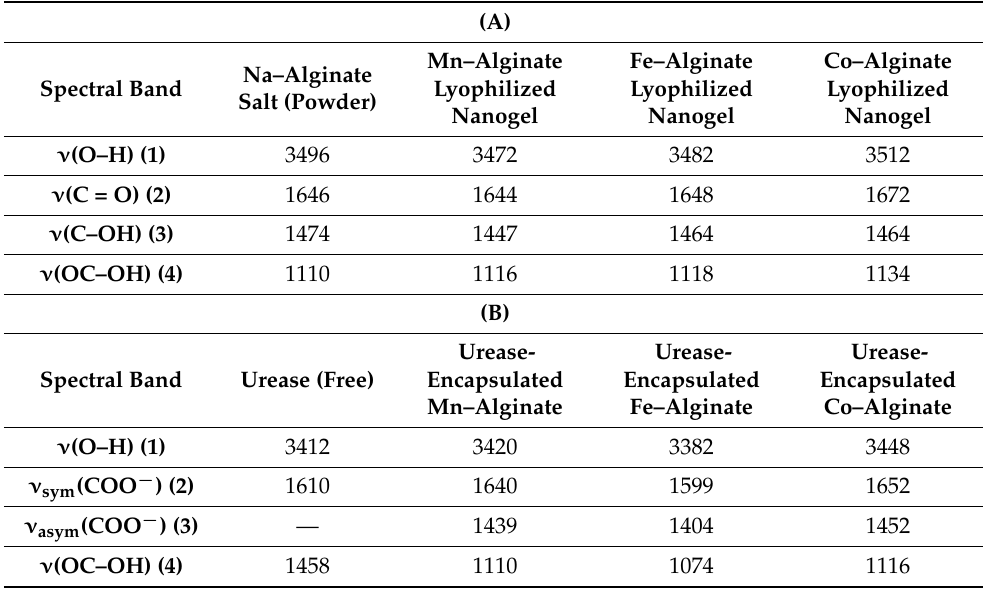
Table 2. ( A ) FT-IR spectral bands of alginate salt and nanogels cross-linked with 3d metallic ions (Mn 2+ , Fe 3+ , and Co 2+ ). ( B ) FT-IR spectral bands of urease (lyophilized) and urease-encapsulated alginate nanogels formed by Mn 2+ , Fe 3+ , and Co 2+